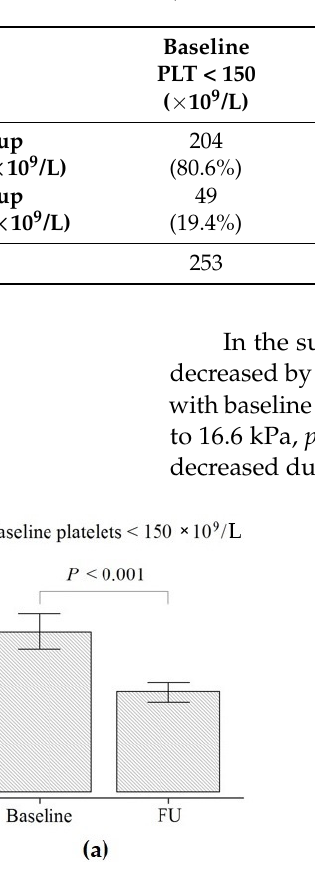
Figure 2. The liver stiffness changes during follow-up according to the baseline platelets count ( a ), albumin levels ( b ) and CHILD ( c ). status.